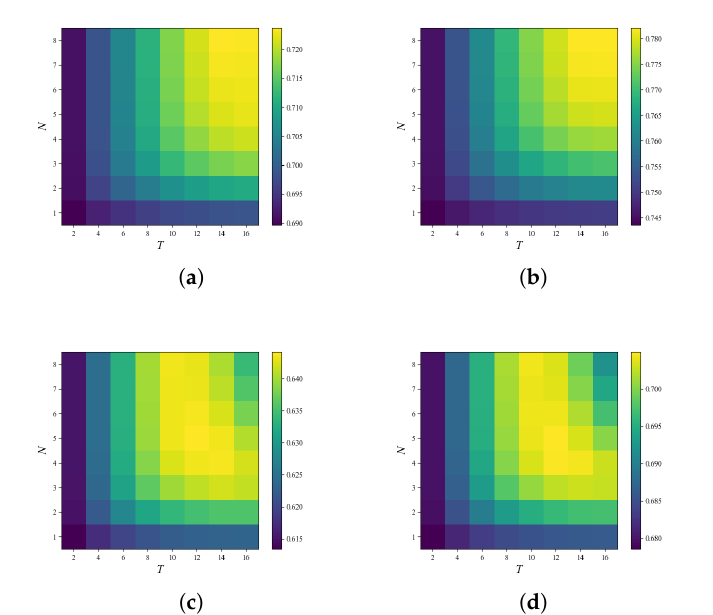
Figure 13. OA of the Potsdam images using different sets of parameters: ( a ) SVM + MCLU + SNSSL on 2_10; ( b ) XGB + BT + SNSSL on 2_10; ( c ) SVM + MCLU + SNSSL on 3_10; ( d ) XGB + BT + SNSSL on